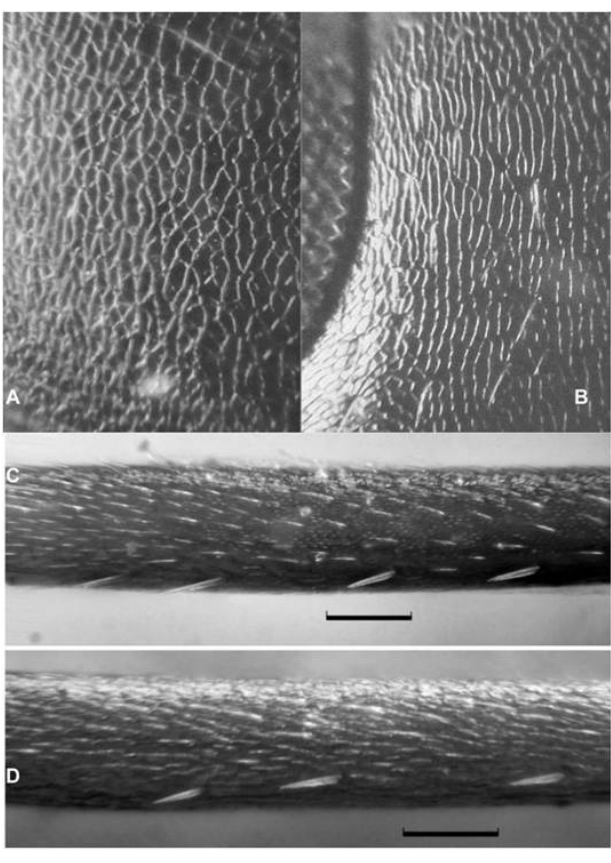
Fig 2 . Detail of microsculpture in F. gerardi (A), coarse and deep creating a matt appearance, and F. fusca (B), superficial. Detail of pubescence in tibiae III, F. gerardi (C) and F. lemani (D); scale bar = 100 micrometers